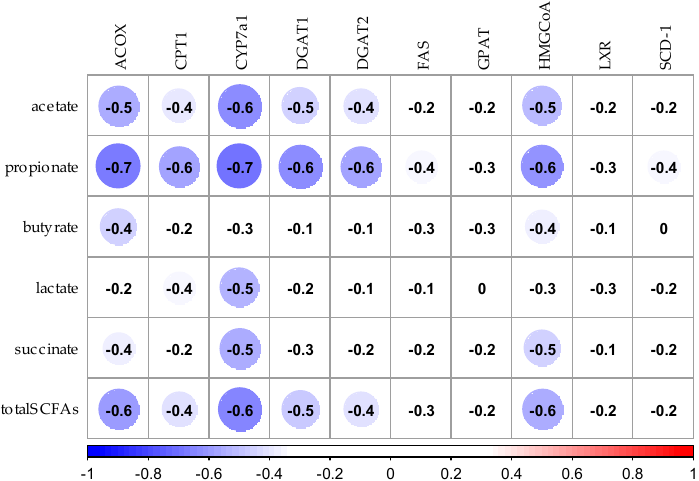
Figure 7. Spearman’s rank correlation analysis between SCFAs and expression of mRNA related to lipid metabolism in the liver. The values in the figure shows the correlation coeffcient. Blue circles show negative correlation and red circles show positive correlation. ACOX, Acyl-CoA oxidase; CPT1, Carnitine palmitoyl Table 1. CYP7a1, Cholesterol 7alpha-hydroxylase 1; DGAT1, Diacylglycerol acyltransferase-1; DGAT2, Diacylglycerol acyltransferase-2; FAS, Fatty acid synthase; GPAT, glycerol-3-phosphate acyltransferase; HMGCoAr, Hydroxymethylglutaryl-CoA reductase; LXR, Liver X receptor; SCD-1, Stearoyl-CoA desaturase 1; total SCFAs, total short-chain fatty acids.